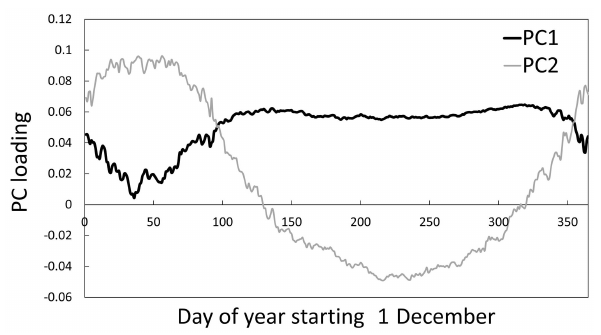
Figure 5. T-mode PCA results showing times when dominant spa- tial phases occurred in water temperatures at 226 sites based on principal component eigenvector loadings during an average year.